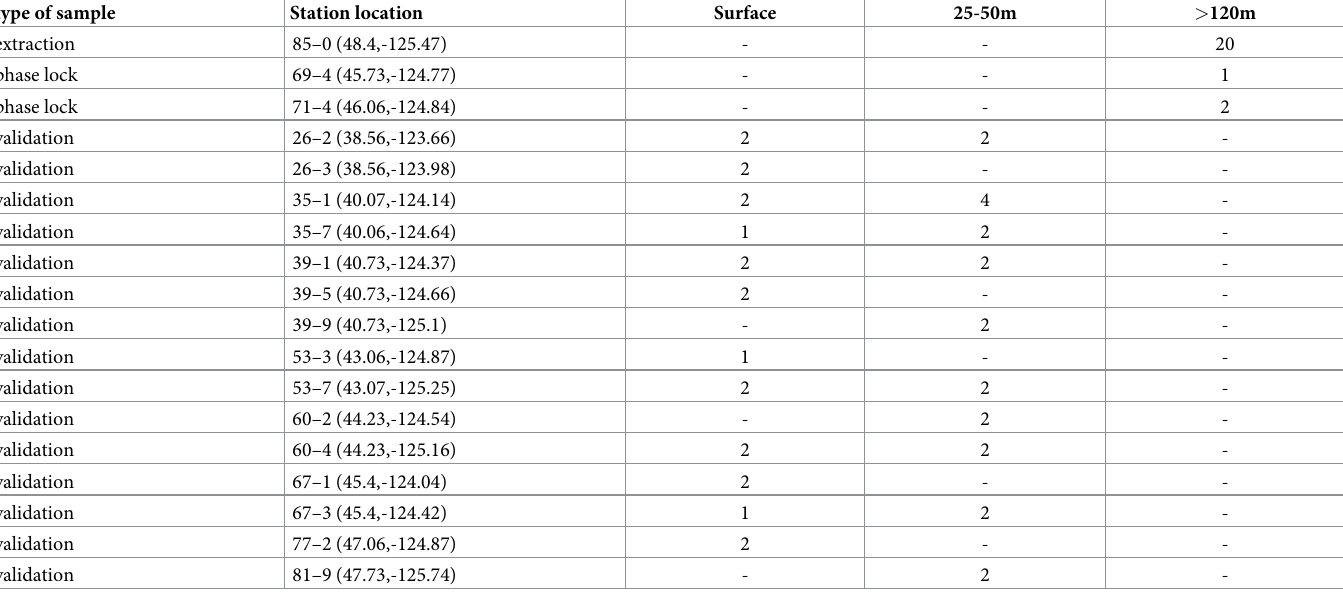
Table 1. Samples analyzed in this study summarized by sample purpose (type of sample), station location (latitude, longitude), and number of samples by